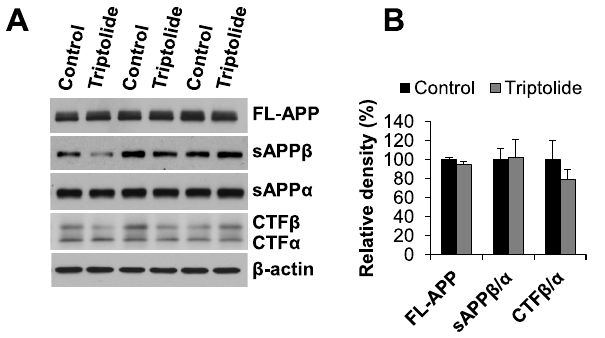
Figure 5. Triptolide treatment does not affect APP processing. A , Immunoblot analysis of full-length APP (FL-APP), carboxyl-terminal fragments (CTF a and CTF b ), and amino-terminal fragment of APP (sAPP a and sAPP b ). B , Densitometric analysis of immunoblots (normalized by the amount of b -actin) with the levels in the control group set as 100%. There were no differences in the amount of FL-APP, the ratio of b -CTF to a -CTF, and the ratio of sAPP b to sAPP a between triptolide treated and control APP/PS1 mice. N=7 mice/group; Age =8.6 months.